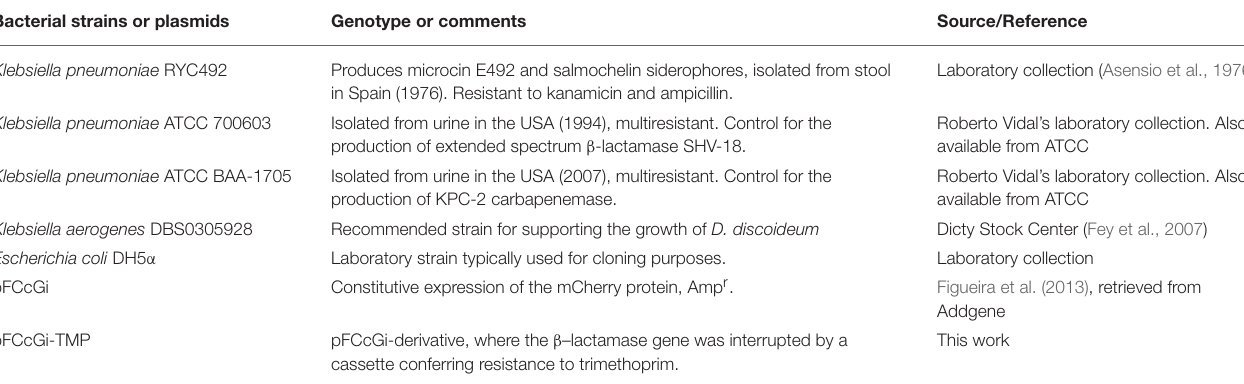
TABLE 1 | Bacterial strains and plasmids used in this